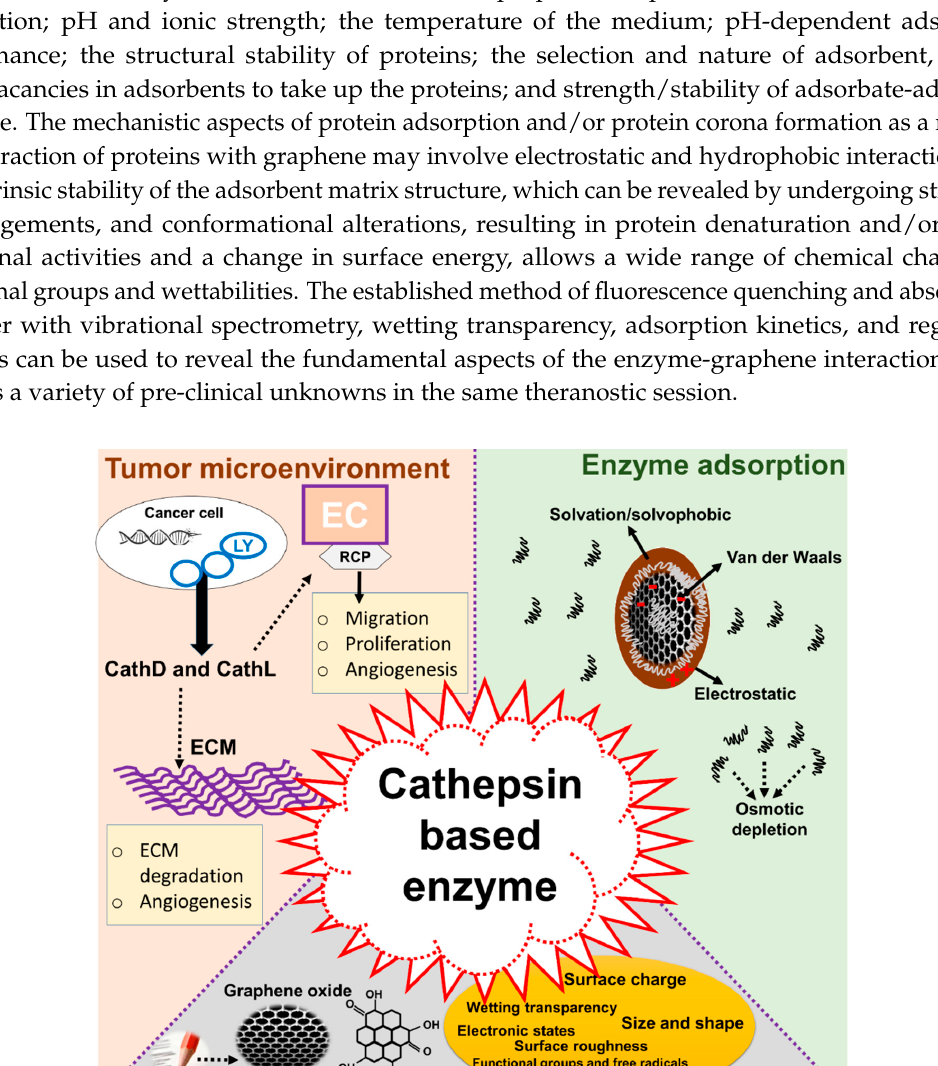
pivotal role in adsorption of such